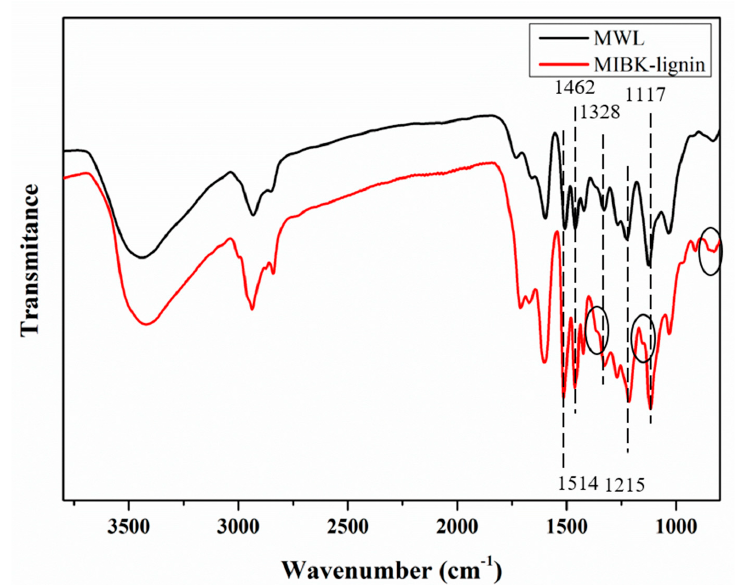
Figure 1. TGA and DTG curves of lignin fractions.